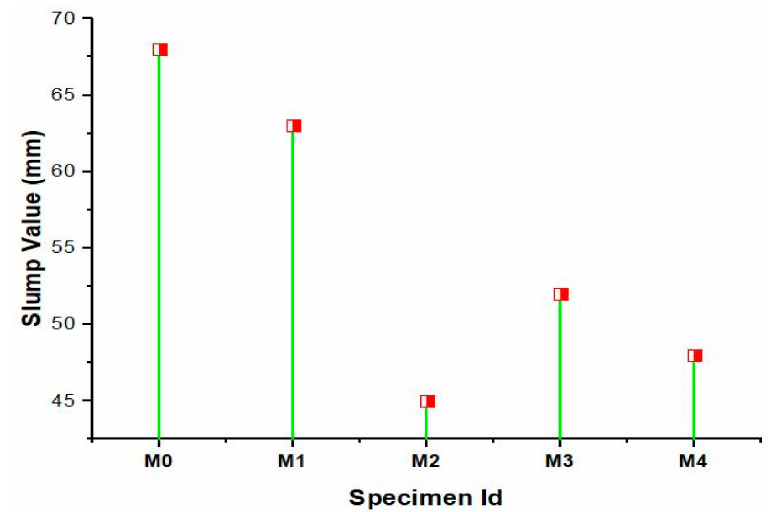
Figure 3. Slump values of various concrete